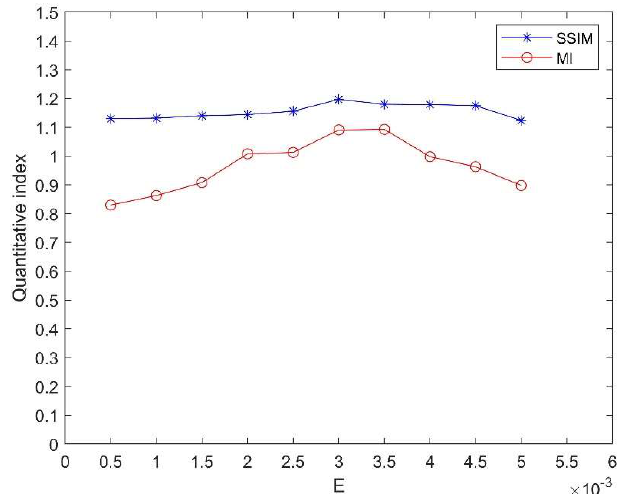
Figure 5. Quantitative evaluation of the fused images produced by different 𝐸 .